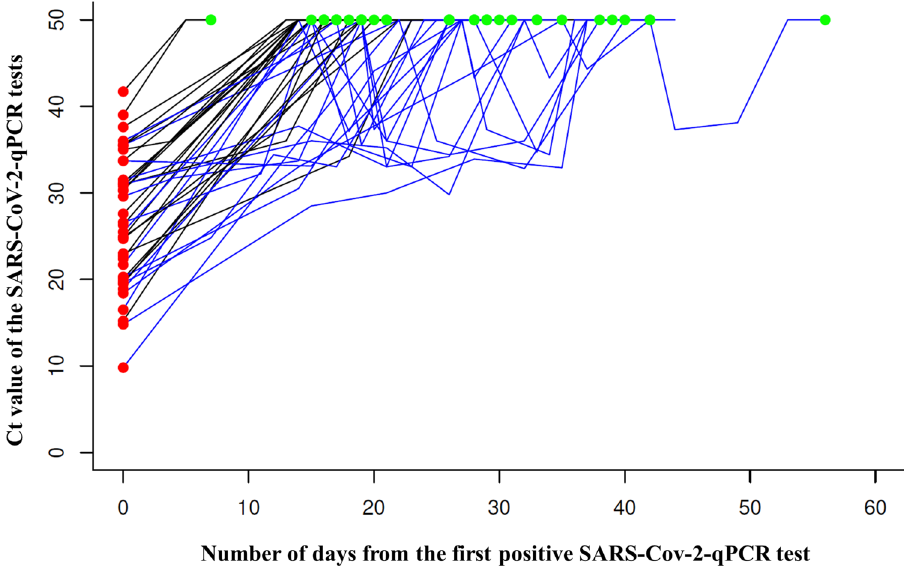
patients from the cohort with two negative tests. The second negative tests are highlighted as green points at the top of the graph. Constantly increasing virus elimination curves are colored black, while fluctuating ones are blue. SARS‑CoV‑2 severe acute respiratory syndrome coronavirus 2, Ct cycle threshold, qPCR quantitative polymerase chain